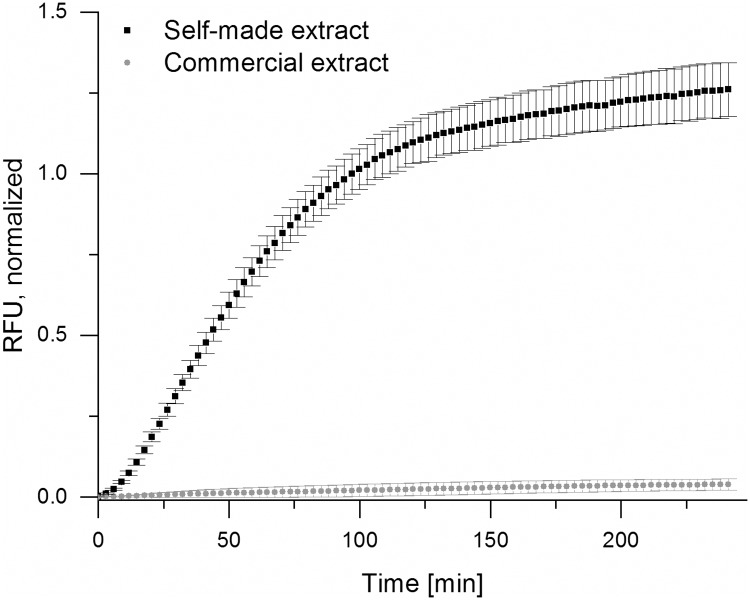
sfGFP production on paper (C350L) with self-made cell extract compared to sfGFP production on paper with a commercial extract provided by Promega.Shown are the mean values of three biological replicates ± standard deviation. Normalization was carried out as described in the Materials and Methods section.